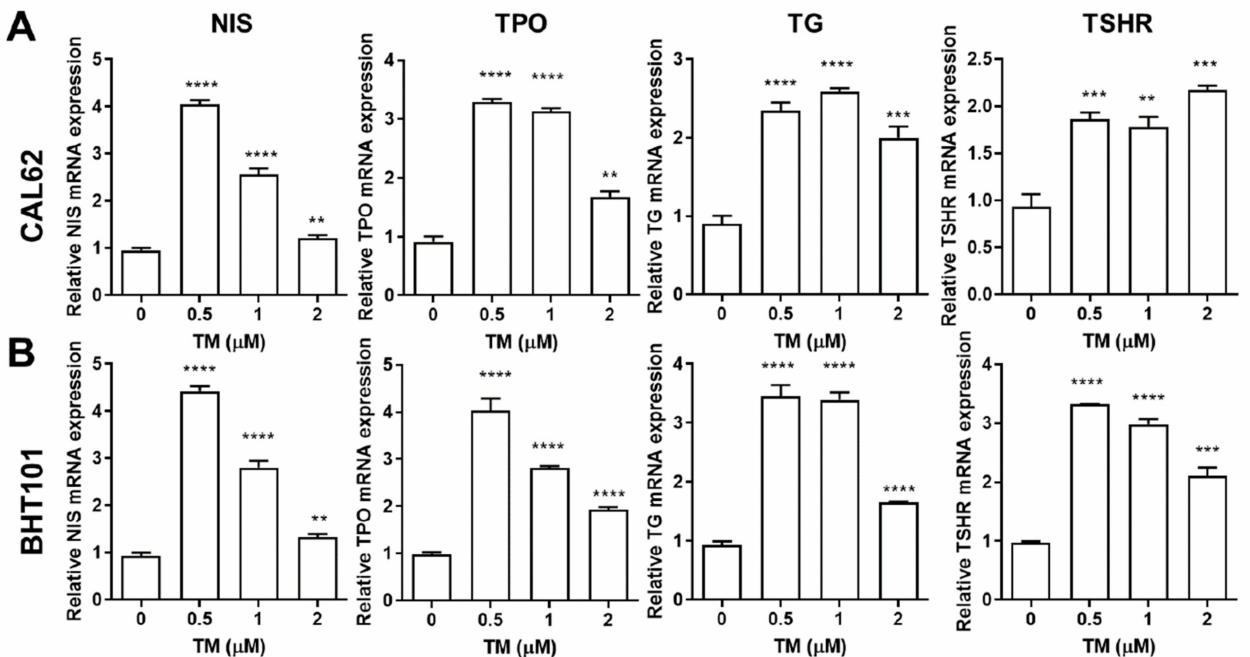
Figure 2. Upregulated mRNA expression of iodide-handling genes. Relative increases in iodide-handling gene expression in TM-treated ( A ) CAL62 and ( B ) BHT101 cells 24 h post-treatment. ** p < 0.005, *** p < 0.0005, **** p < 0.0001 compared to absence of tunicamycin. Data are the mean ± SD of three samples per